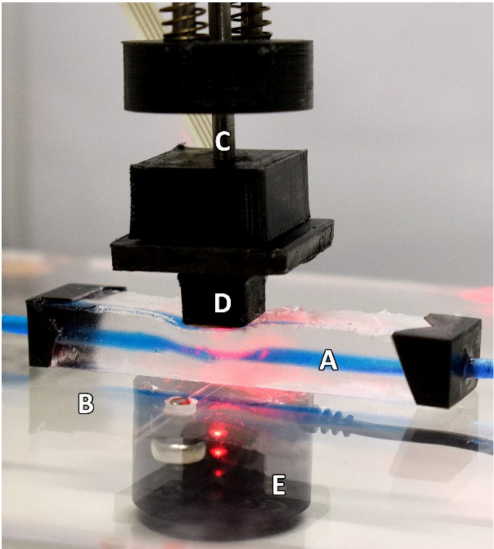
Figure 2. The experimental setup as seen during the continually applied pressure part of the protocol. The Phantom ( A ) is resting on a force-sensing plate ( B ) whilst the linear actuator ( C ) is descending. The PPG sensor ( D ) is seen resting on the phantom in this example during the descending phase of the protocol. The loadcell ( E ) can be seen under the force-sensing plate. For illustrative purposes, this depiction shows the use of a blue dye to highlight the artificial vessel better.